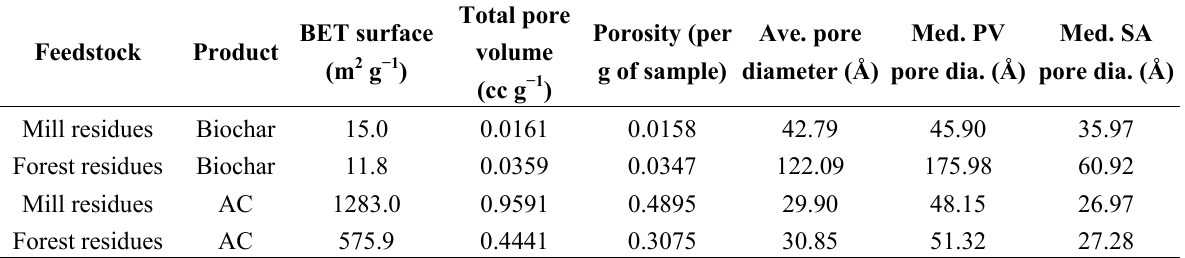
Table 4. BET surface area and pore characteristics of TEA system biochars and AC resulting from steam activation in a rotary calciner at 815